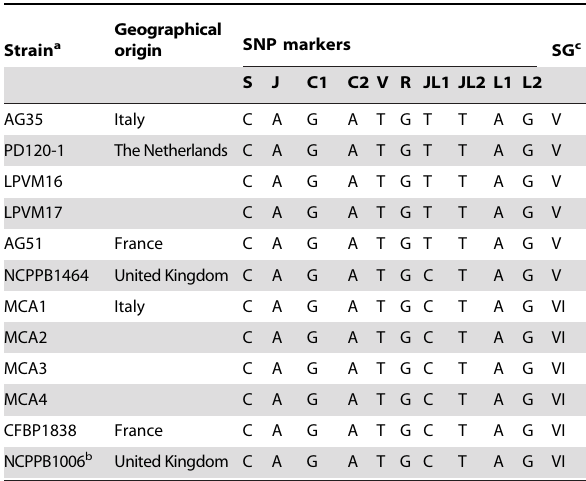
Table 1. P. savastanoi strains used in this study with the designation of their geographical origin, the variants for each SNP marker examined and their